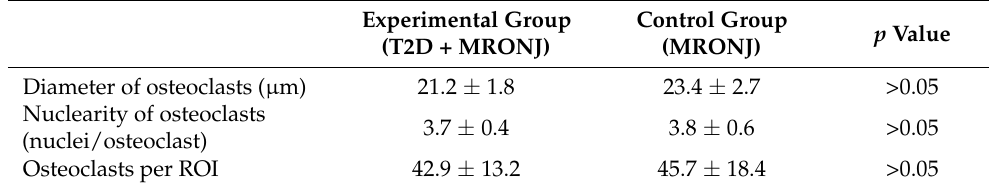
Table 2. Histomorphometric and quantitative analysis of patients (H&E staining).